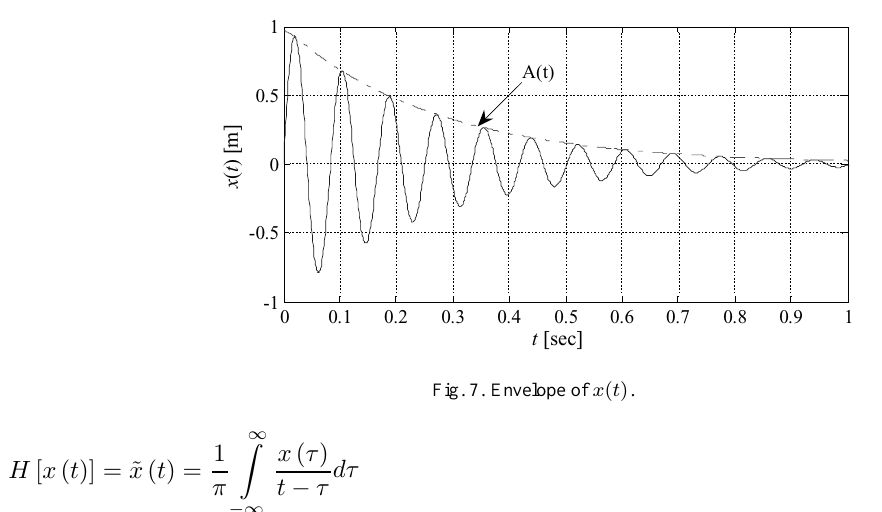
Fig. 7. Envelope of x ( t )